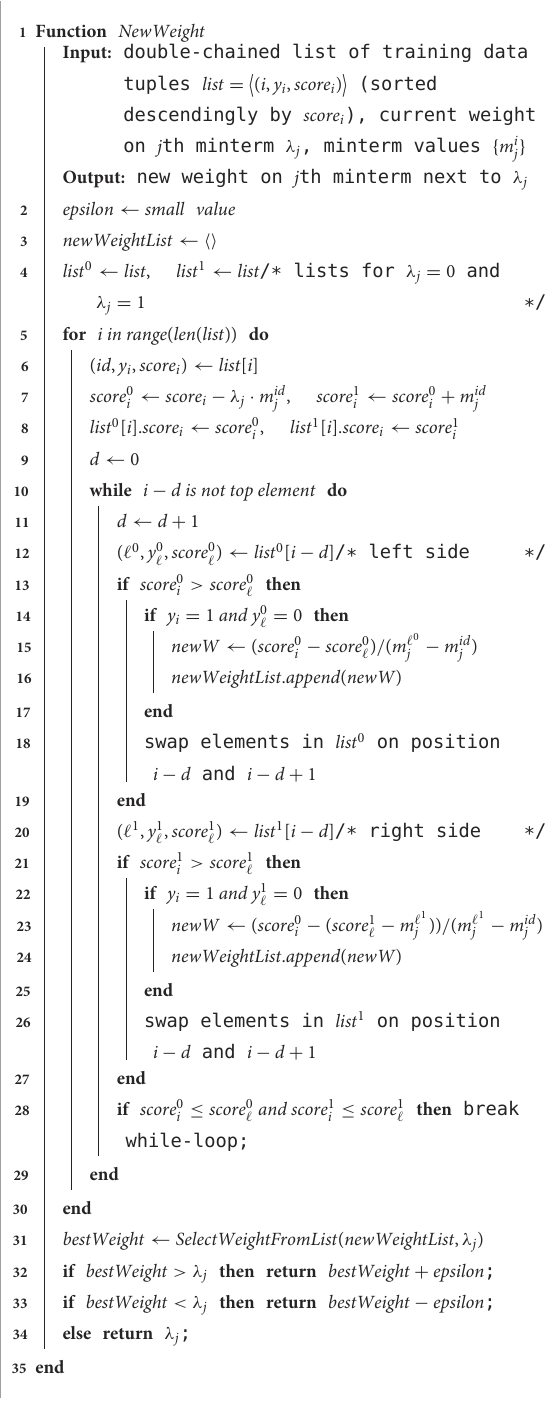
Algorithm 3. Generates new minterm weight next to λ j by checking changes of the order if λ j would be 0 (left side)